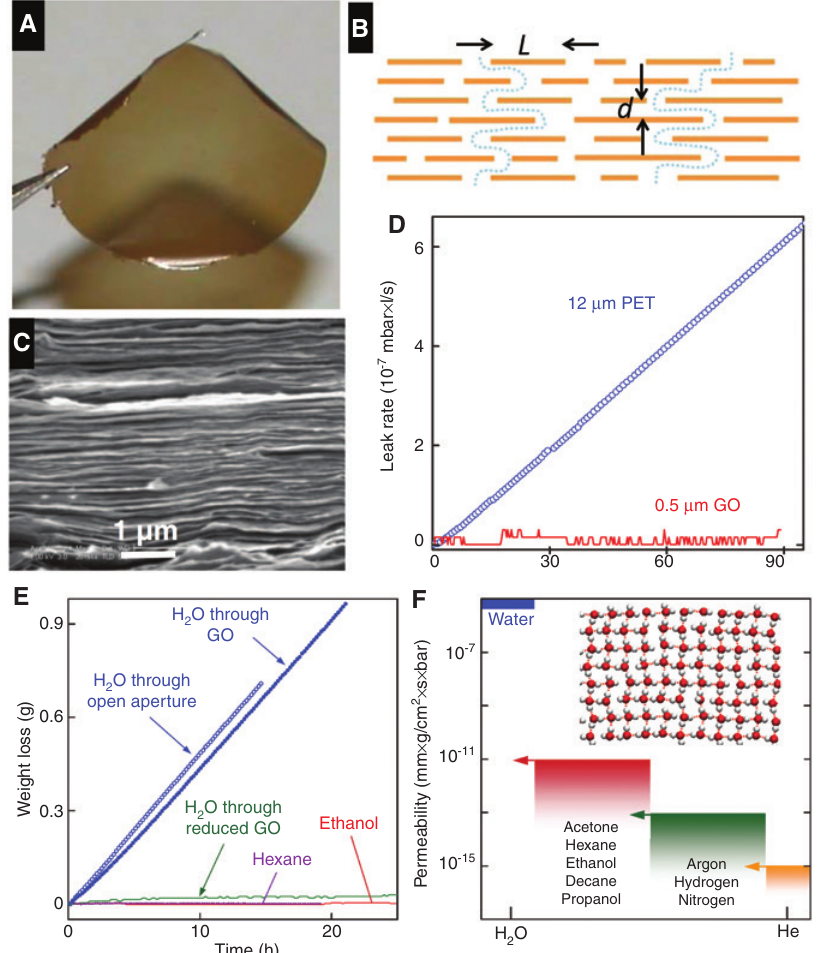
Figure 6: Image of a typical freestanding GO membrane prepared by vacuum filtration. Adapted from Nair et al. [91]. (A) Optical photograph of a film. (B) SEM cross-sectional image showing the structure of the film. (C) Model of permeation through the GO film. (D) Leak rate of helium across a polyethylentherephtalate film and GO. (E) Evaporation of water, hexane, and ethanol across the GO membrane. (F) Compari- son of different gas and liquid permeabilities against